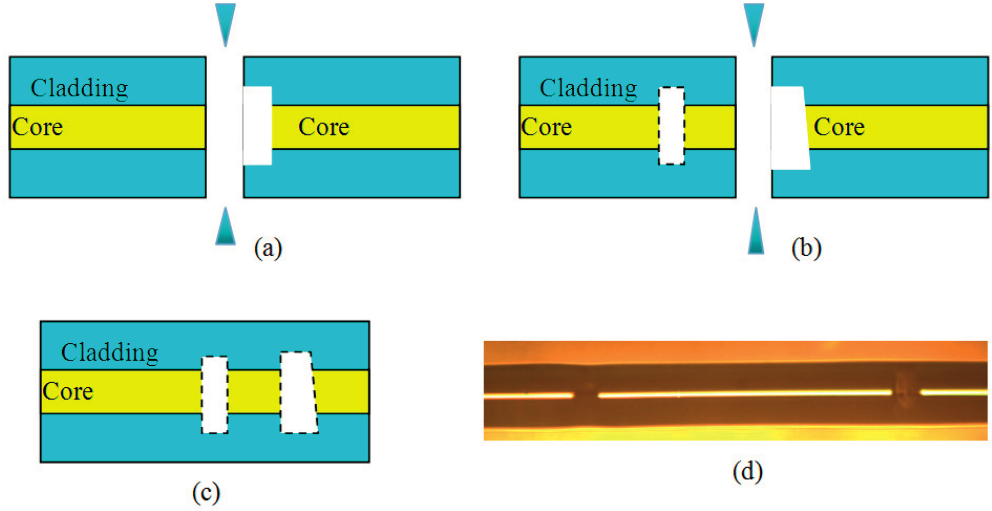
Figure 2. Fabrication and configuration of high temperature and high pressure sensor ( a ) fabrication the first air cavity; ( b ) fabrication the second air cavity; ( c ) configuration of sensor; ( d ) photograph of sensor from